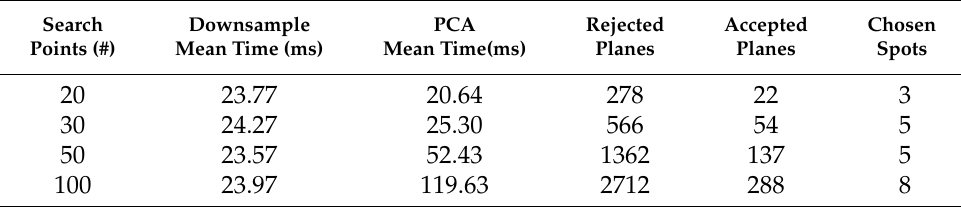
Table 4. Results for the simulation of the second case.